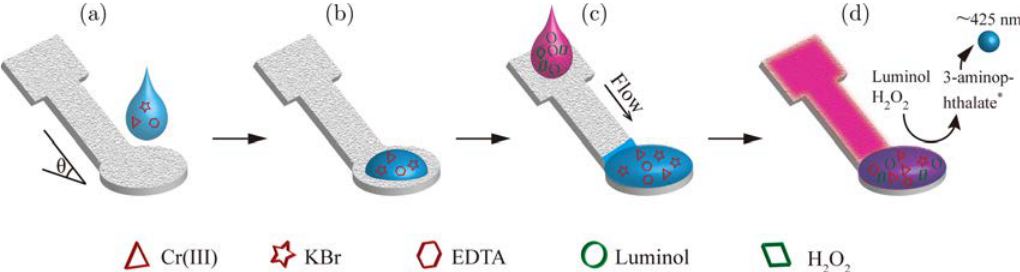
Fig. 2. Schematic representation of GCF-CL assay on the paper-based micro°uidic device. (a, b) The test solution drops into the center of detection zone and spreads under capillary action; (c, d) the substrate solution is added into the loading zone, and °ows into the detection zone to mix with the test solution for triggering the CL under the action of gravity and capillary